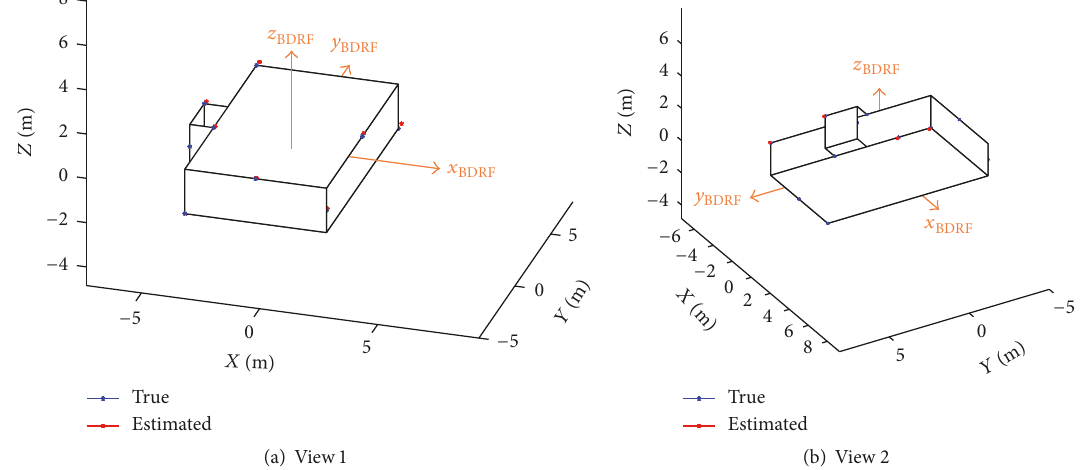
Figure 7: True versus estimated 3D position of the tracked body points.